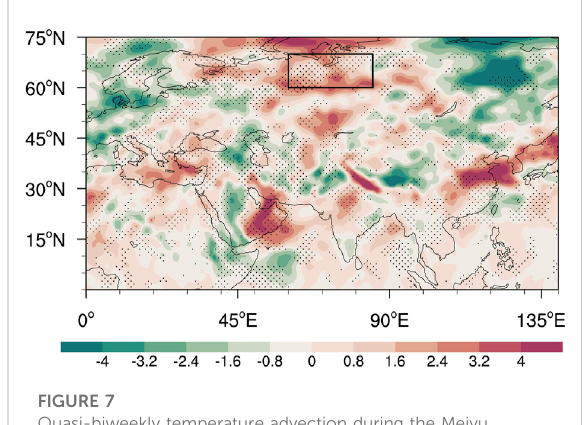
FIGURE 7 Quasi-biweekly temperature advection during the Meiyu onset period (unit: 10 − 5 K s − 1 ; dots are the areas with statistical signi fi cance exceeding the 95% level).